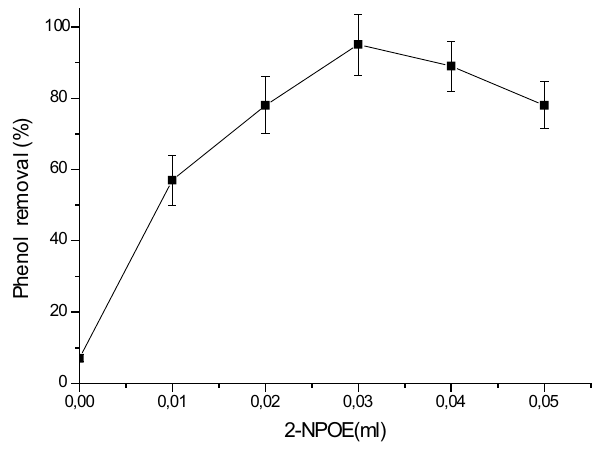
Fig. 4 Effect of plasticizer (2-NPOE) content on the transport of phe- nol. Transport conditions: feed phase: phenol 10 −3 M, pH 2. Stripping phase: NaOH 0.20 M. Membrane: 12.60 cm 2 of surface area, calix[4] resorcinarene: RC8 (0.15 g/g mixture of polymers), (0–0.05 ml 2-NPOE/12.56 cm 2 mixture of polymers) values obtained after 6 days of transport